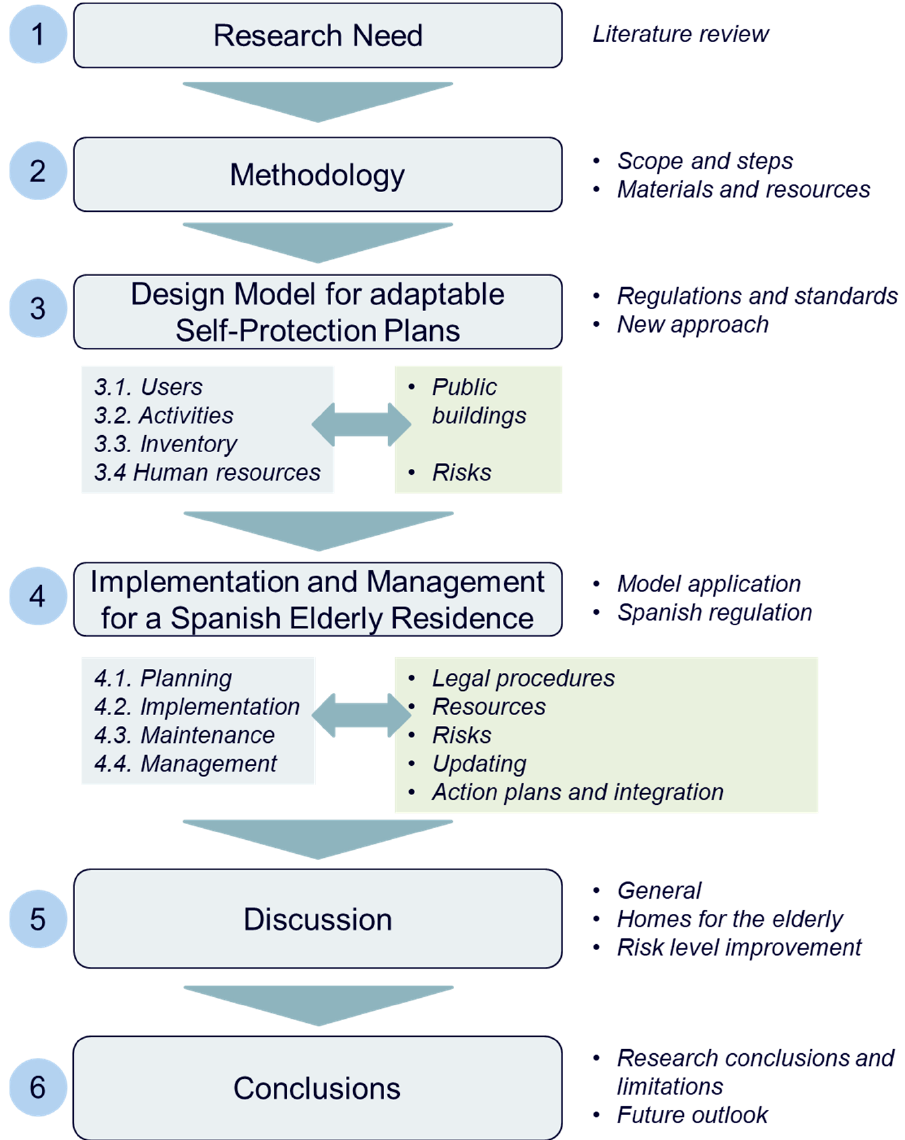
Figure 1. Research methodological steps (own elaboration).